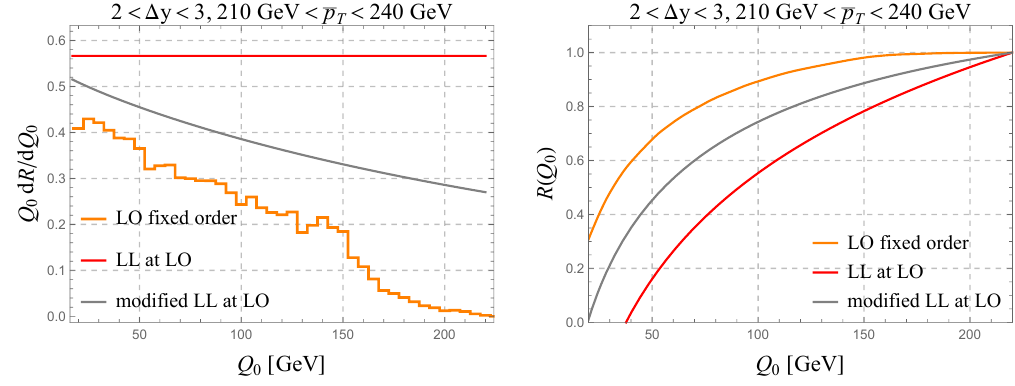
Figure 7 . One emission at LL accuracy, compared to the full LO result. The modi(cid:12)ed LL shown as a gray line is obtained by implementing momentum conservation for the soft